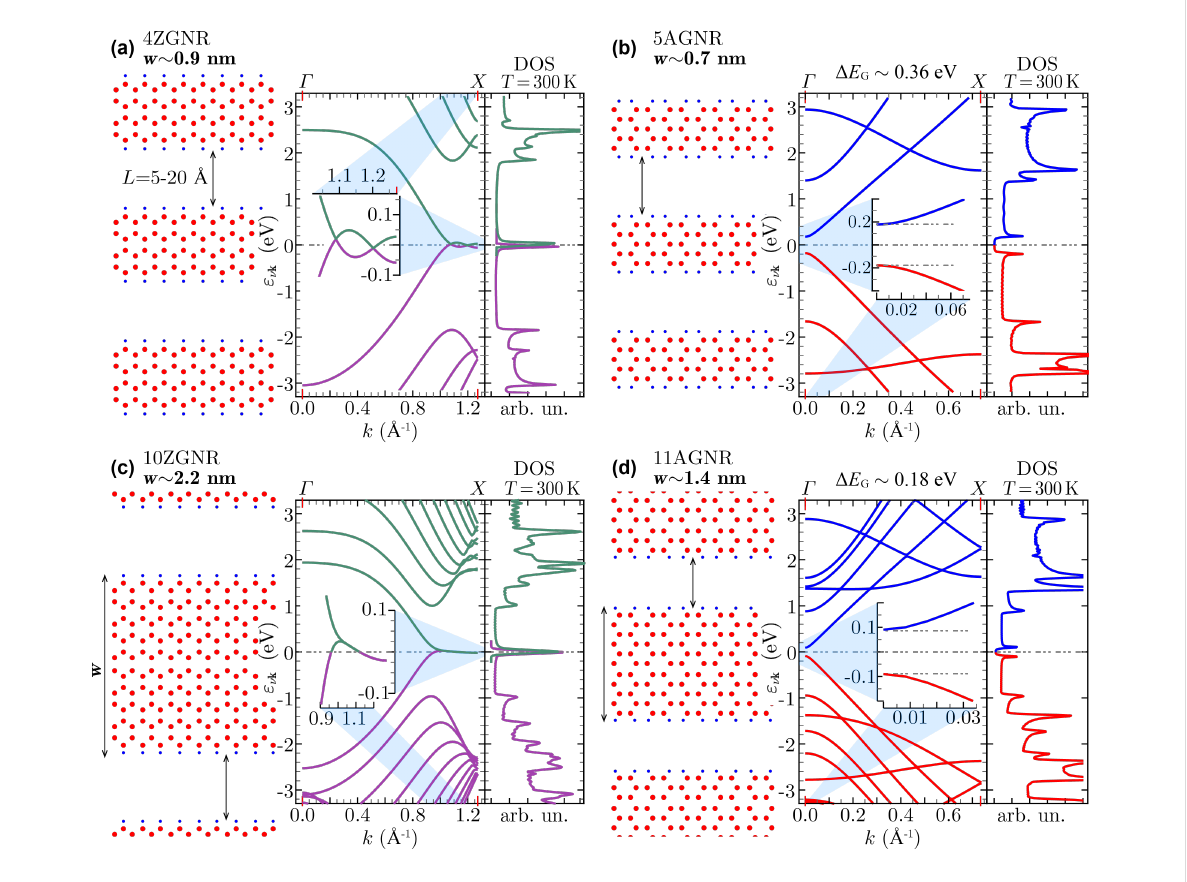
Figure 1: Geometry, LDA band-structure and DOS of the different (zigzag and armchair) GNR arrays reported in the present study, namely 4ZGNR (a), 5AGNR (b), 10ZGNR (c), and 11AGNR (d). In the LDA, the ZGNRs are gapless, while the AGNRs have a band gap Δ E G , which decreases with increasing the ribbon width w , as attested by the insets in the band plots. The ground-state features of the systems are strongly sensitive to the value of the C–C bond-length (here fixed to 1.42 Å) and the ribbon width, while they are practically unaffected by in-plane vacuum distances L (here fixed to 15 Å). Figure 1a and Figure 1b are adapted from Figure 1 of